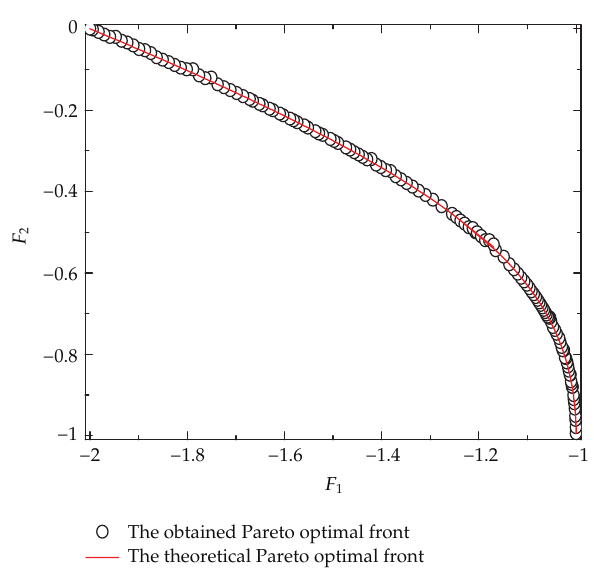
Figure 1: The obtained Pareto optimal front of Example